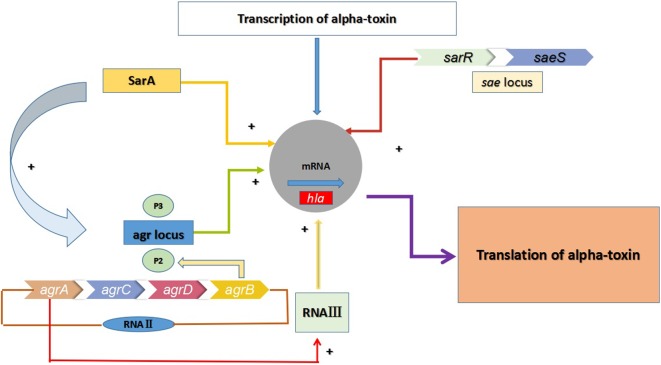
Multiple regulatory factors regulate the expression of hla. The agr locus encodes two transcripts known as RNAII and RNAIII, which are transcribed from the P2 and P3 promoters. The regulatory RNA molecule RNAIII can up-regulate the expression of hla, and agrA is an essential transcription factor for RNAIII. RNAII encodes AgrB, AgrD, AgrC, and AgrA. Meanwhile, the expression of hla in MRSA is also regulated by the two-component regulatory system SaeRS (saeR and saeS)and the SarA protein family.